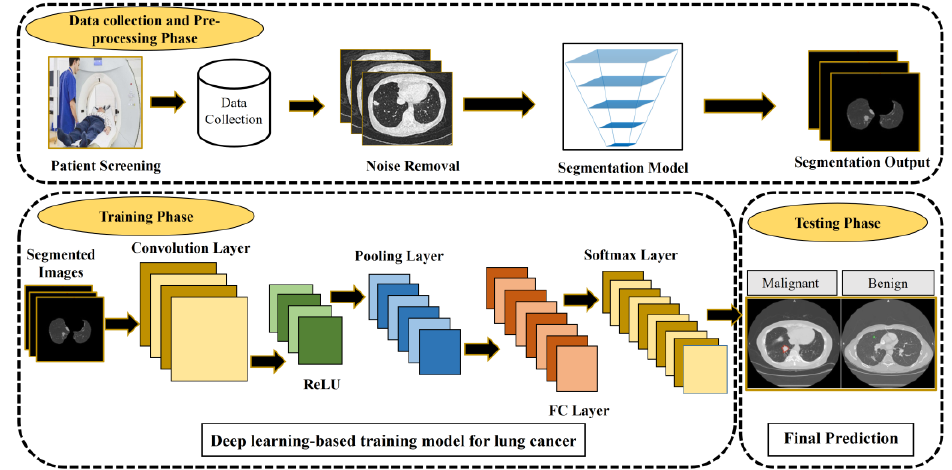
Figure 1. CAD-based lung cancer detection system [14]. The figure is reused from reference [14];